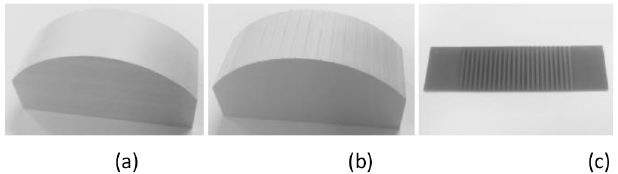
Fig. 5. The stimuli. (a) A PVC strip with smooth surface. It is the prototype shape in Experiment 1 and one of the real reference stimuli in Experiment 2. (b) A PVC strip with textured surface. It is the prototype shape in Experiment 1. (c) A texture model (Gratings are single sided copper on printed circuit boards). It is the prototype shape in Experiment 1 and one of the real reference stimuli in Experiment